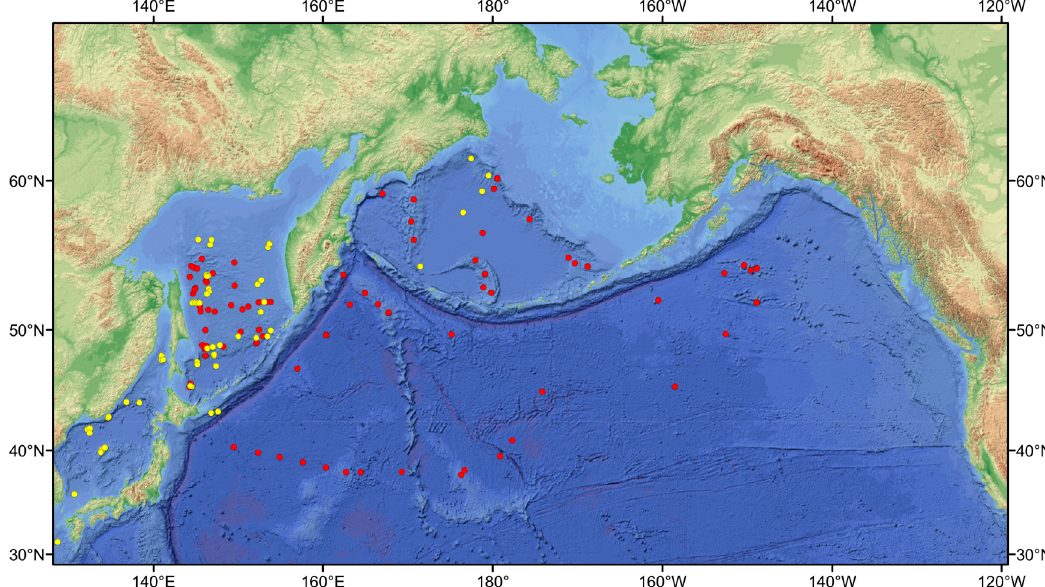
Figure 8. Sino–German Network of sites with high-quality sediment cores in the subarctic Pacific. German sediment coring campaigns in red (KOMEX I and II, KOMEX-SO178, KALMAR, INOPEX), and Chinese FIO sediment cores in yellow. For orientation, the water depth is shown as bluish colors.